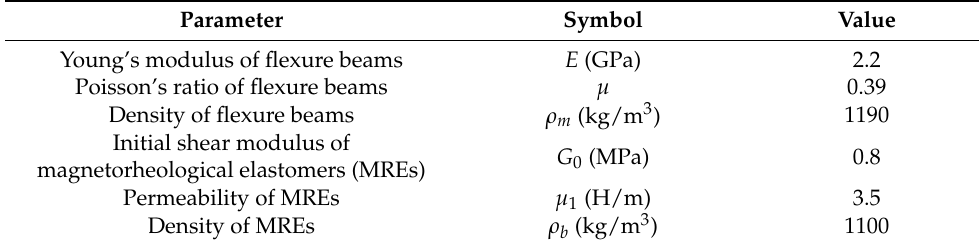
Table 1. Material parameters of the nanopositioner.